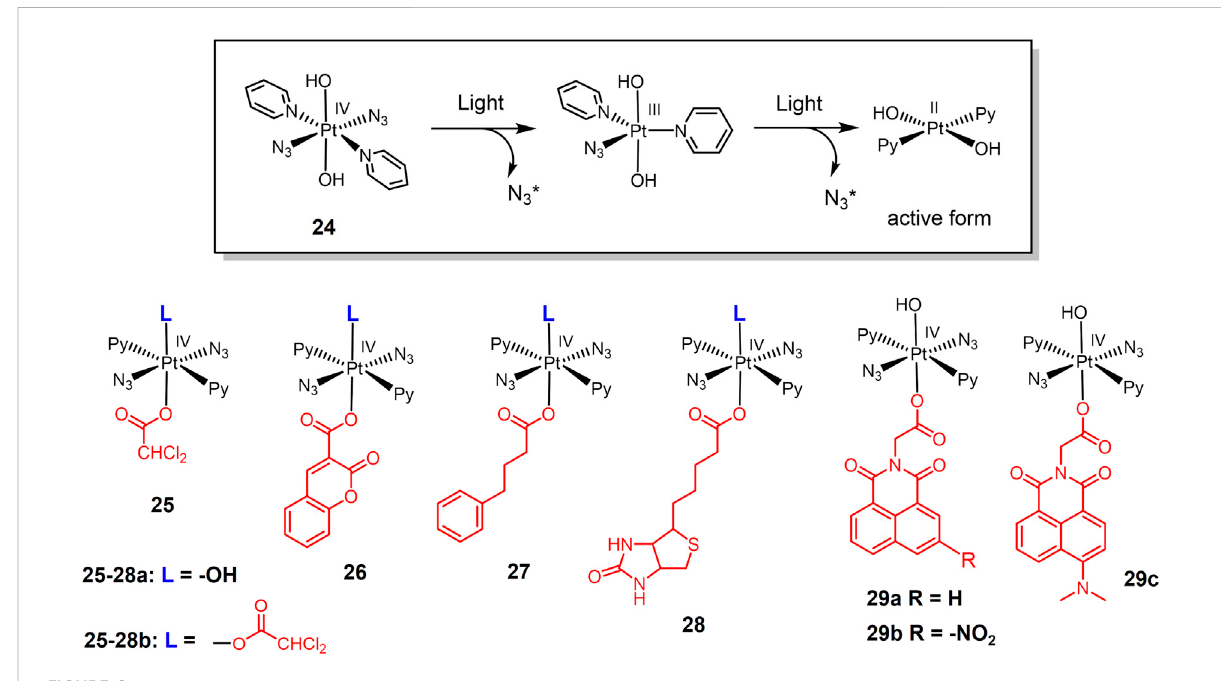
FIGURE 6 Light-responsive Pt(IV) prodrugs as PACT